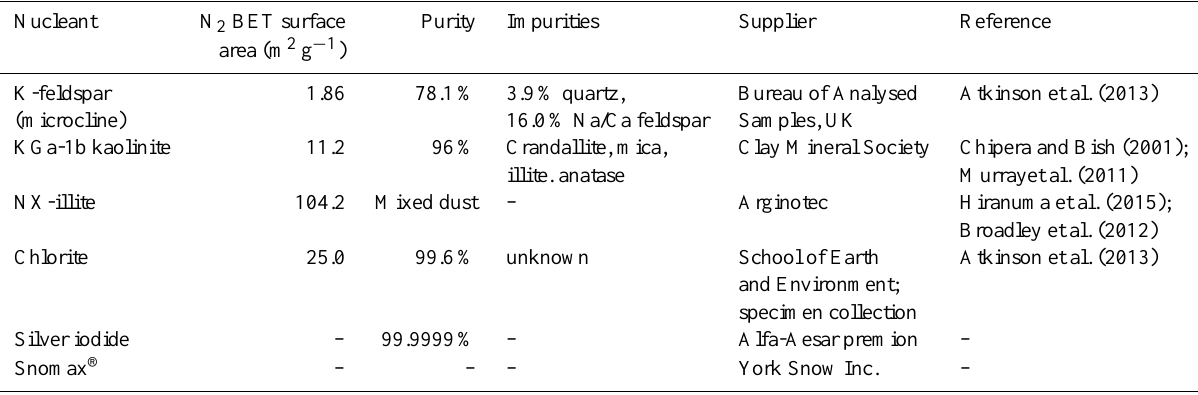
Table 2. Characteristics of the materials used in this study. For silver iodide and Snomax ® BET surface areas are not reported. Nucleant N 2 BET surface Purity